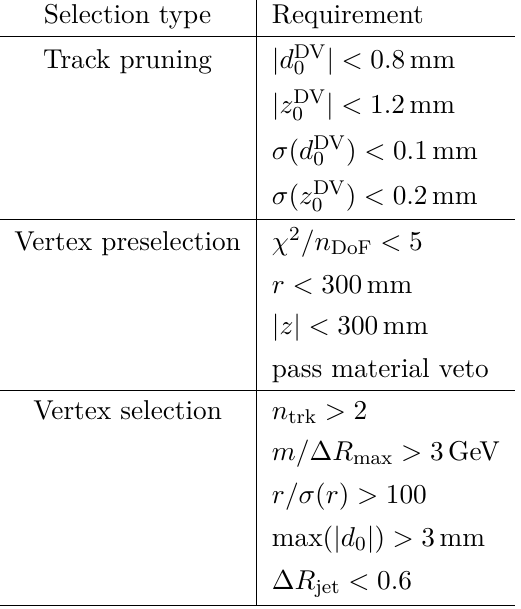
Table 1 . The full set of selection criteria applied to